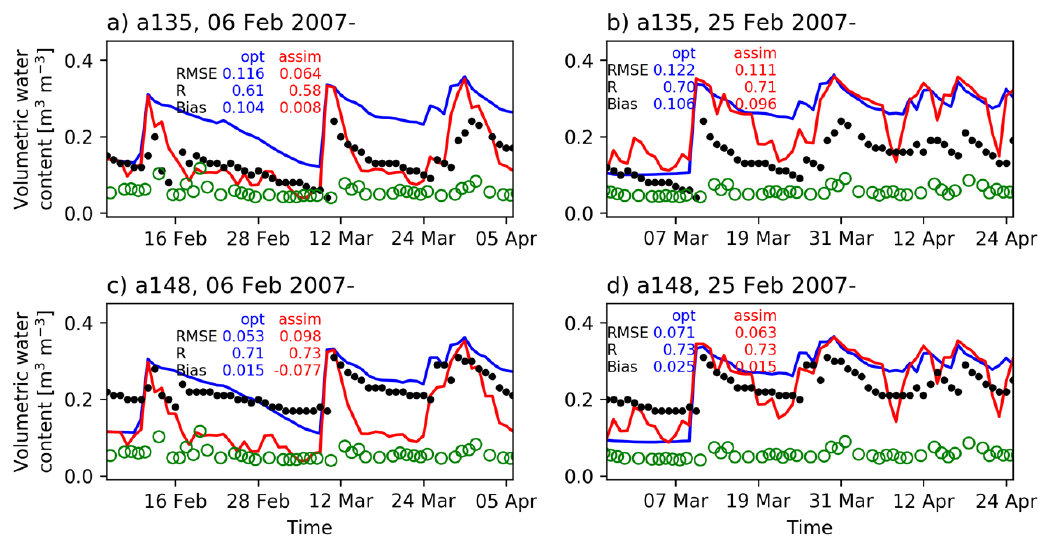
Figure 7. Time series of surface soil moisture (m 3 m -3 ) from the optimized model (blue), assimilated model (red), observation (black dot), and AMSR-E soil moisture (green circle) at ( a ) a135 from 6 February 2007, ( b ) a135 from 25 February 2007, ( c ) a148 from 6 February 2007, and ( d ) a148 from 25 February 2007 in Little Washita. Each case was simulated 60 days from the initial date. Skill metrics are indicated on each figure as the root-mean-square error (RMSE, m 3 m -3 ), correlation coefficient (R), and mean bias (m 3 m − 3 ).